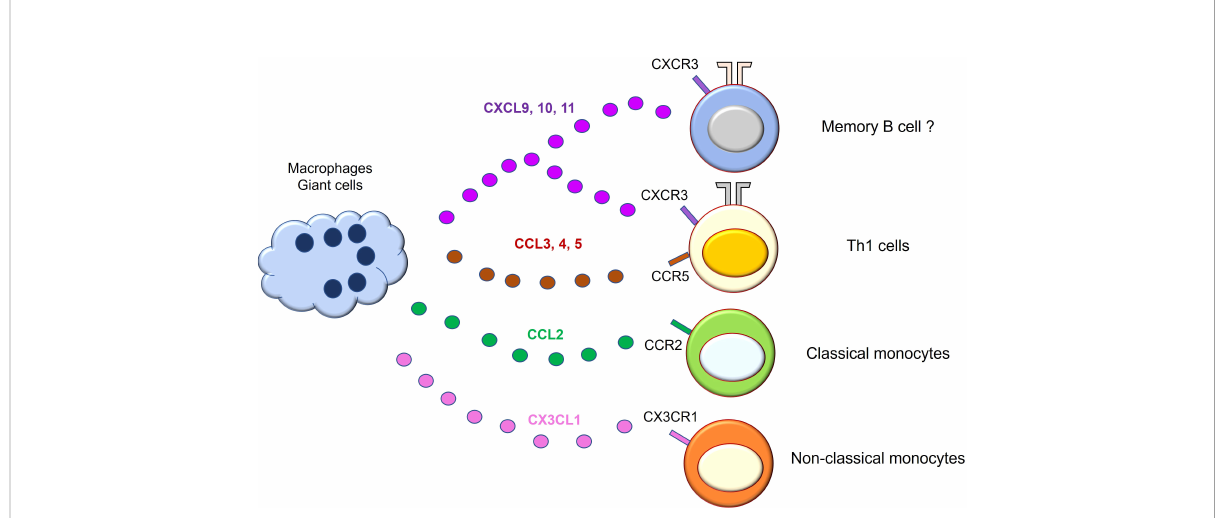
FIGURE 3 Macrophages/giant cells are professional chemokine producers in giant cell arteritis. Macrophages/giant cells in the vascular lesion of giant cell arteritis actively engage in chemokine production. The released chemokines amplify vascular in fl ammation by mobilizing cells that express the corresponding chemokine receptors. CXCL9, 10, and 11 recruit Th1 cells and memory B cells through CXCR3 receptor on the cell surface. CCL3, 4, and 5 recruit T cells expressing CCR5. CCL2 recruits CCR2-expressing classical monocytes. CX3CL1 mediates non-classical monocyte mobilization through CX3CR1 receptor. CCL, C-C motif Chemokine Ligand; CXCL, C-X-C motif Chemokine Ligand; CXCR, C-X-C Motif Chemokine